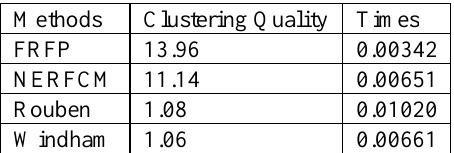
Table 11 Averages of 100 trials using proximity matrices